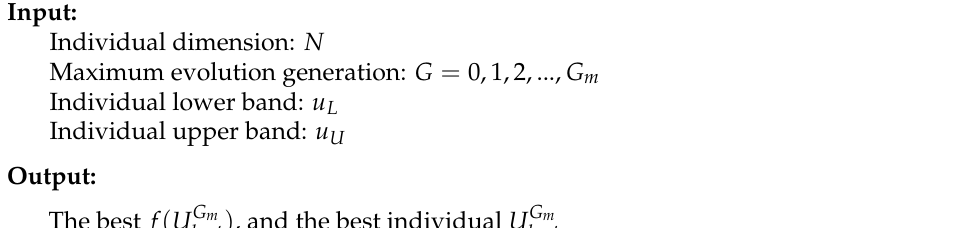
Algorithm 1 The optimization process of